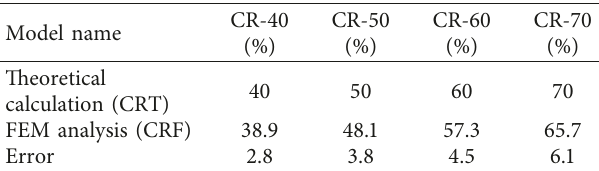
Table 7: Value of CR.